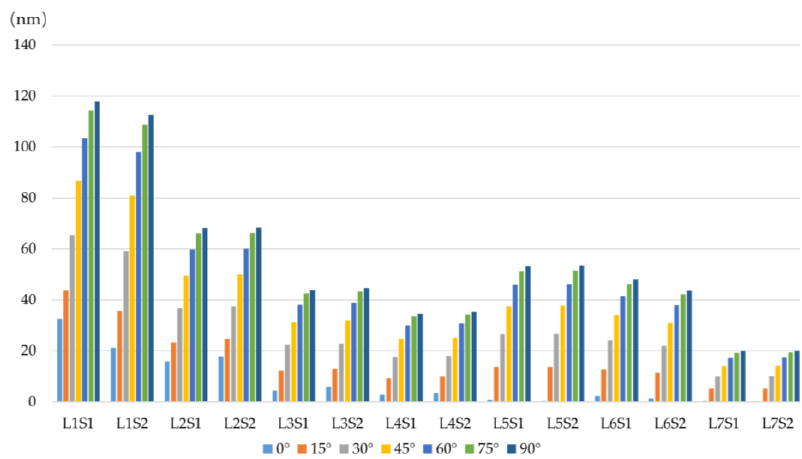
Figure 13. RMS of optical surfaces.